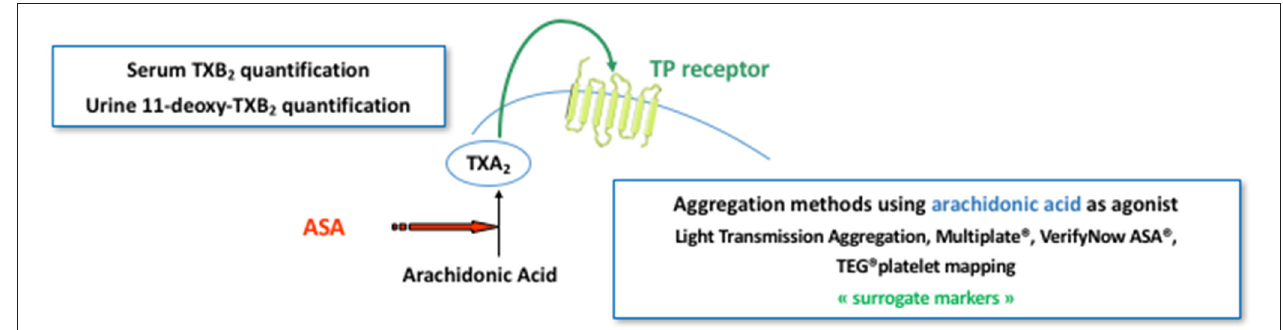
FIGURE 4 | Pharmacodynamics of ASA. ASA pharmacodynamics can be evaluated using either an aggregation-based method evaluating the in vitro platelet capacity to be activated with arachidonic acid or by assessing the in vivo biosynthesis of thromboxane A 2 via the quantification of its stable metabolite, namely thromboxane B 2 (TXB 2 ) in serum or 11-deoxy-TXB 2 in urine. Aggregation-based method could be performed using the gold standard method for platelet function analysis, i.e., light transmission aggregometry, or one of the commercialized point-of-care tests, mainly Multiplate ® , VerifyNow ASA ® , and TEG ® platelet mapping.